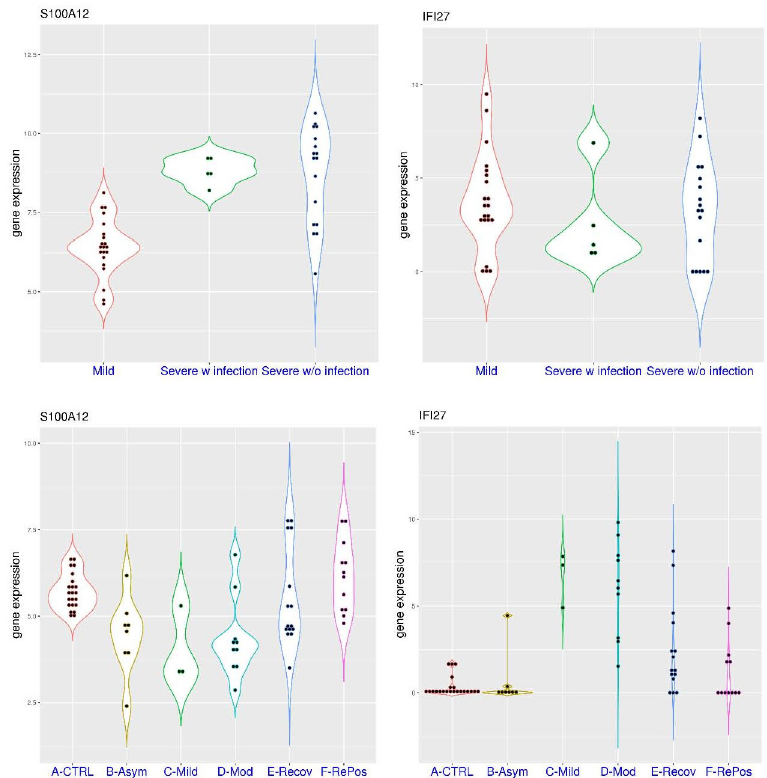
Fig 9. Expression levels of S100A12 and IFI27 in peripheral blood mononuclear cells (PBMCs) as markers for the infection in COVID-19 patients. A) upper panel (dataset GSE184401), comparison of S100A12 and IFI27 expression in COVID-19 patients with different severity (mild or severe) and secondary infection (with or without). B) lower panel (dataset GSE179627), comparison of S100A12 and IFI27 expression in healthy controls and COVID-19 patients with different severity (asymptomatic, mild and moderate) and different stages (acute, recovering and re-positive).